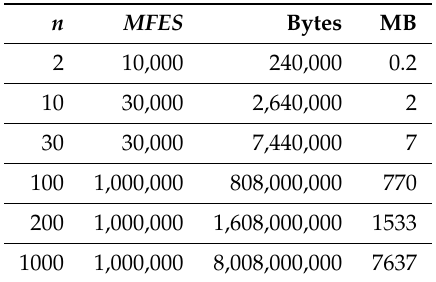
Table 1. Theoretical calculation of needed memory.